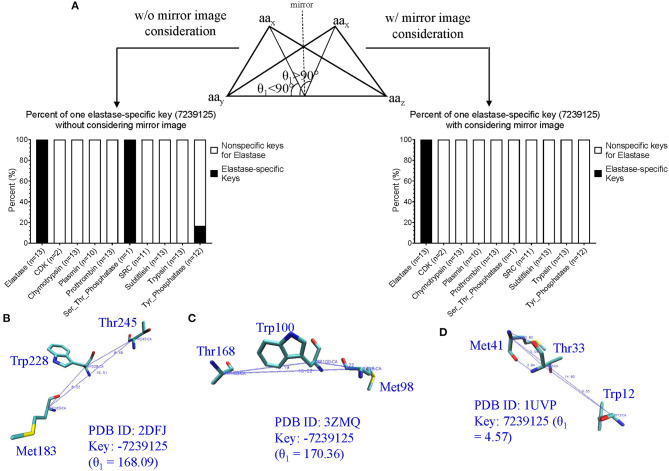
The effect of the mirror-image keys on specific keys for elastases. (A) Two triangles are considered as mirror images if they meet the criteria: (i) the same amino acids, (ii) having θ1 < 90° for one triangle and θ1 > 90° for another triangle, (iii) the bin is the same for θ of the triangle with θ1 < 90° and 180°-θ of the triangle with θ1 > 90°. The specific keys are represented as percentage; (B–D) The representative keys are shown for Ser/Thr phosphatase, Tyr phosphatase and elastase, respectively. The PDB IDs, θ1, and keys are indicated.